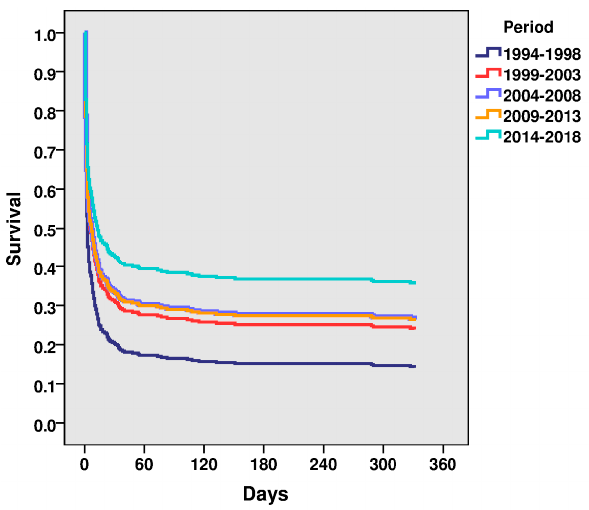
Figure 3. One-year Cox regression multivariate analyses. Table 4. Multivariable Cox regression analyses for ICCU mortality, 30-day case fatality and 1-year all-cause mortality.